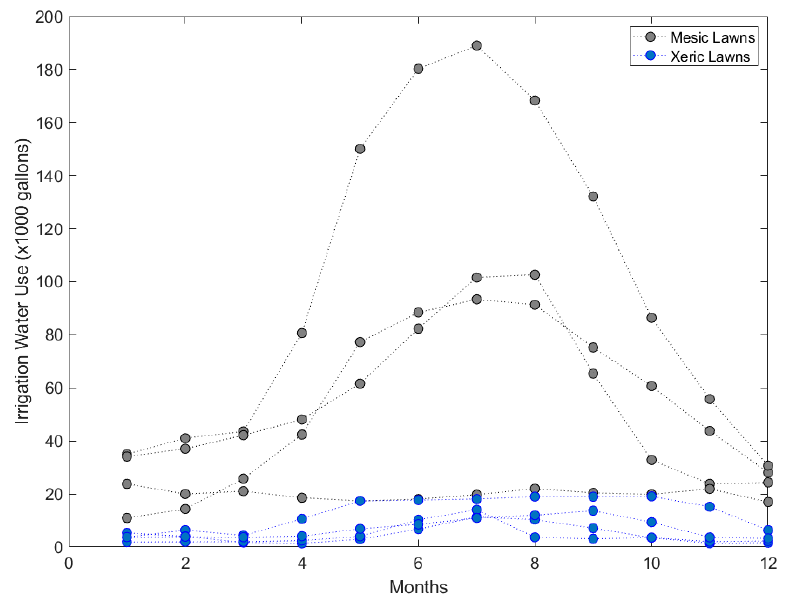
Figure 5. Scatter plot of irrigation water use of four mesic and xeric lawns of the houses in Las Vegas Valley; each data point is a three-year average of irrigation water use provided by LVVWD.